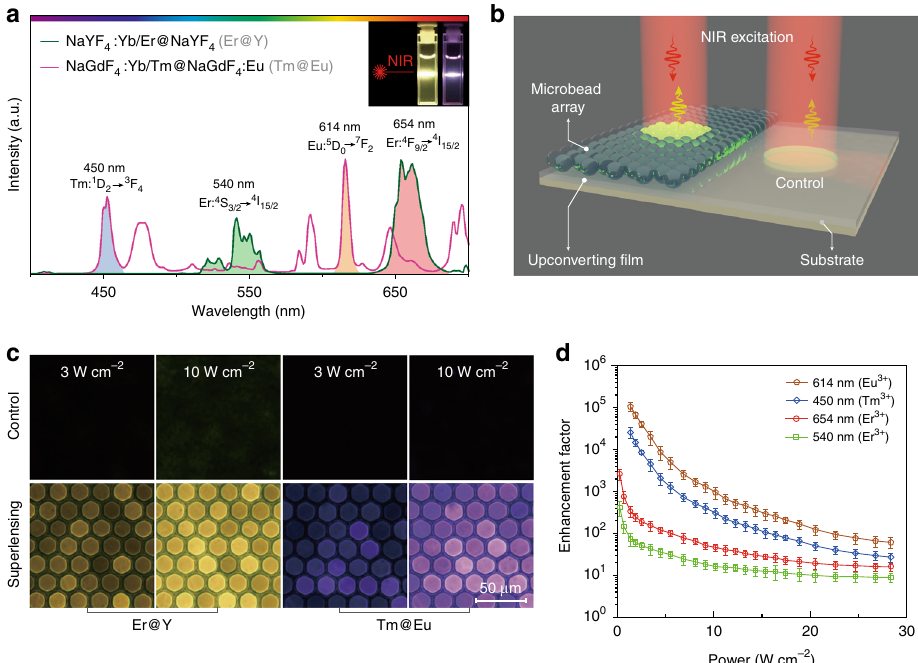
Fig. 2 Experimental investigations on upconversion luminescence ampli fi cation through dielectric superlensing. a Upconversion emission spectra of NaYF 4 : Yb/Er@NaYF 4 and NaGdF 4 :Yb/Tm@NaGdF 4 :Eu core-shell nanoparticles recorded under 980 nm laser excitation (~20W cm − 2 ). (Inset) Corresponding photos of the nanoparticles dispersed in cyclohexane upon 980 nm excitation. b Schematic illustration of the experimental setup designed